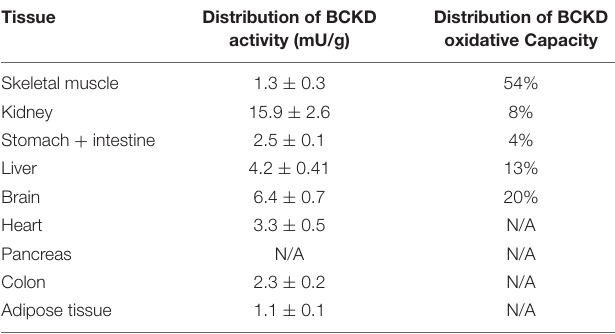
Table re-drawn and modified from Suryawan et al. (1998). BCKD, branched-chain ketoacid dehydrogenase; BCAA, branched-chain amino acids; g, grams of tissue; mU, milliunits; N/A, not